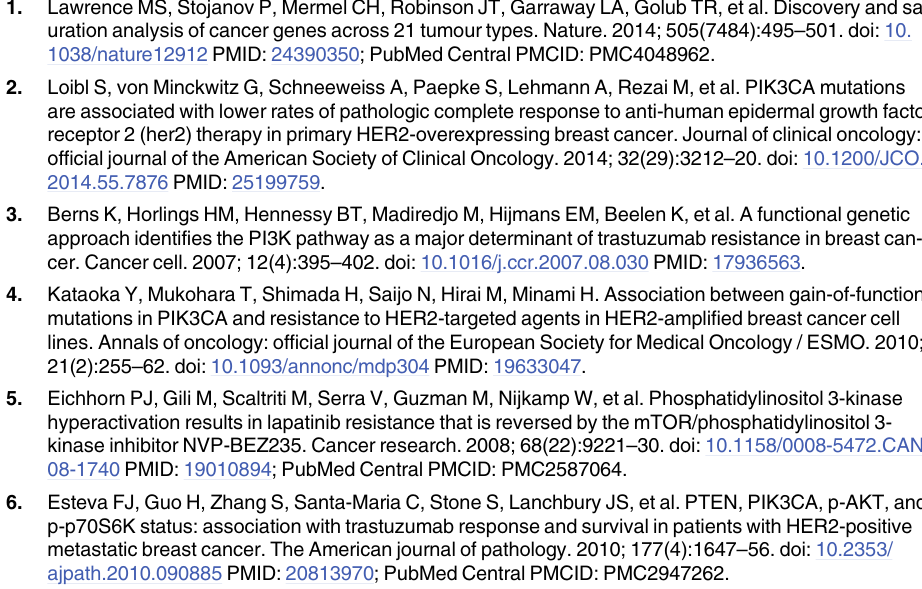
S1 Fig. Overall quality assessments of included studies (QUADAS-2 tool). S2 Fig. Graphical depiction of residual-based goodness-of-fit (A), bivariate normality (B), influence and outlier detection analysis (C and D, respectively).